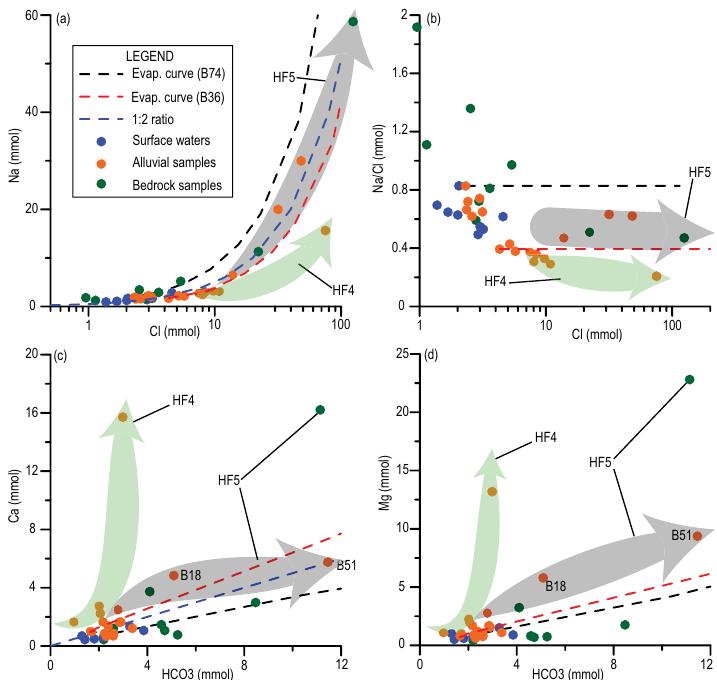
Figure 6. Major and minor ions plotted against the theoretical evaporation curves for fresh groundwater from the upper catchment (B74) and the Lower Catchment (B36). Evaporation curves were calculated using PHREEQC (Parkhurst and Appelo,